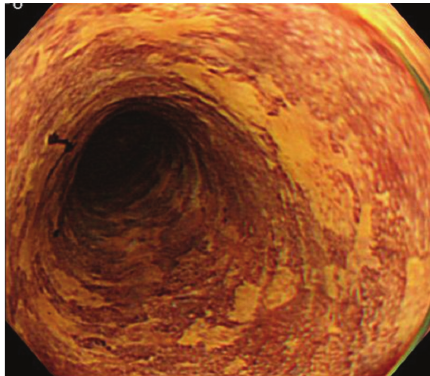
Figure 2: Lugol chromoendoscopy image of many irregularly shaped multiform Lugol-voiding lesions (grade D Lugol-voiding